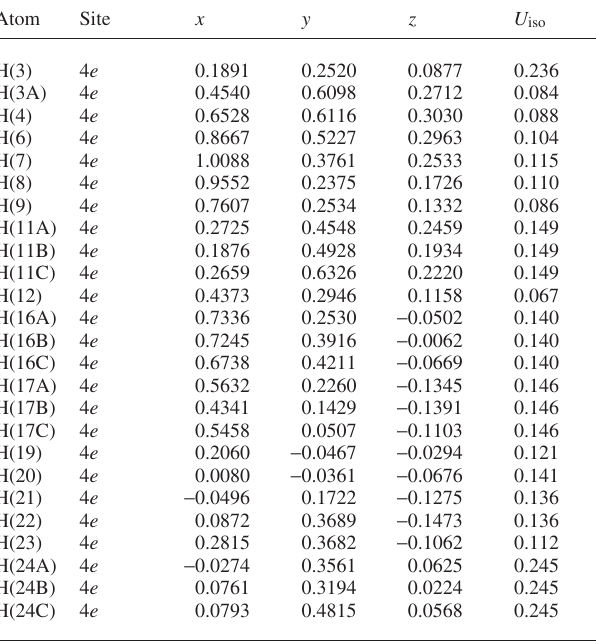
Table 2. Atomic coordinates and displacement parameters (in Å 2 )